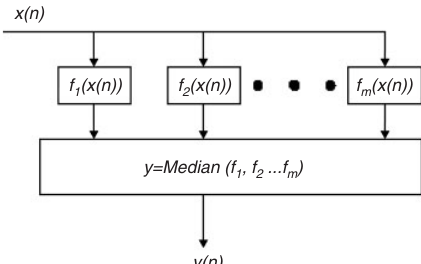
Figure 6 General structure of the FMH filter.